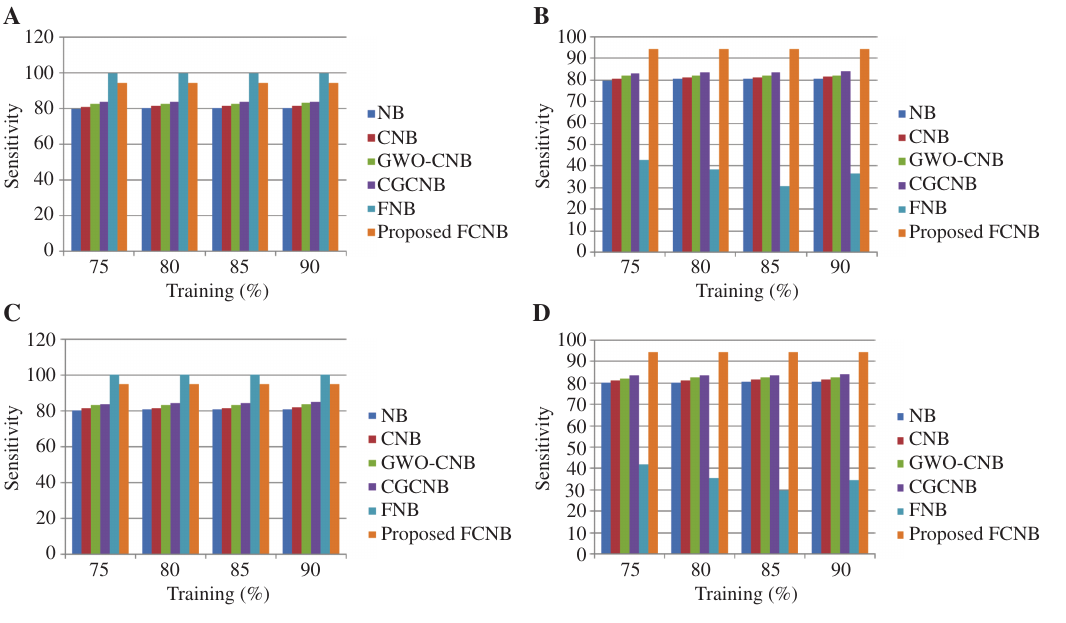
Figure 4: Comparative Analysis of the FCNB Classifier Based on Sensitivity. For mapper = 4 in (A) localization dataset and (B) skin dataset. For mapper = 5 in (C) localization dataset and (D) skin